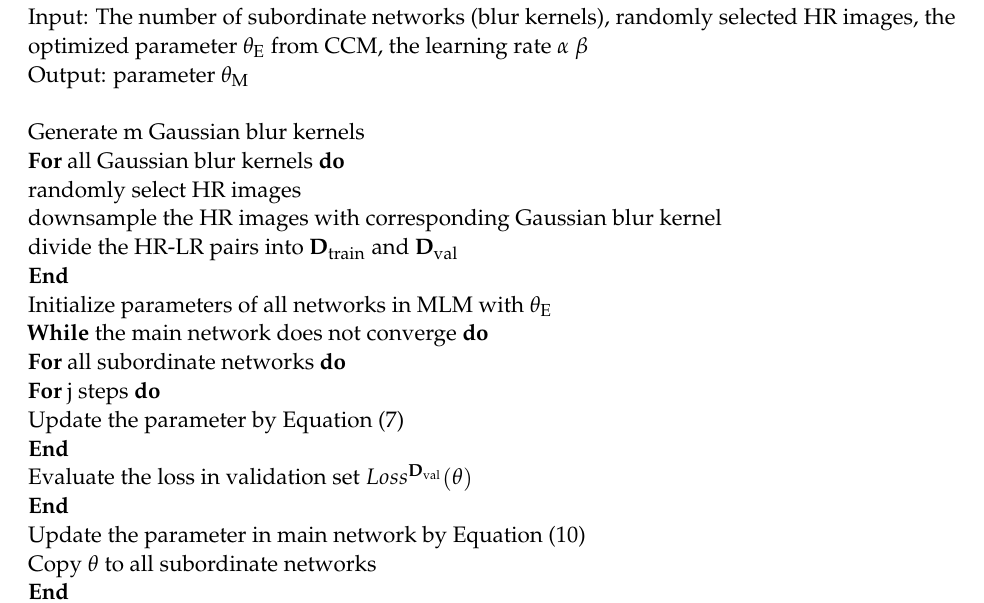
Algorithm 1. Training process in a multiple-blur-kernel learning